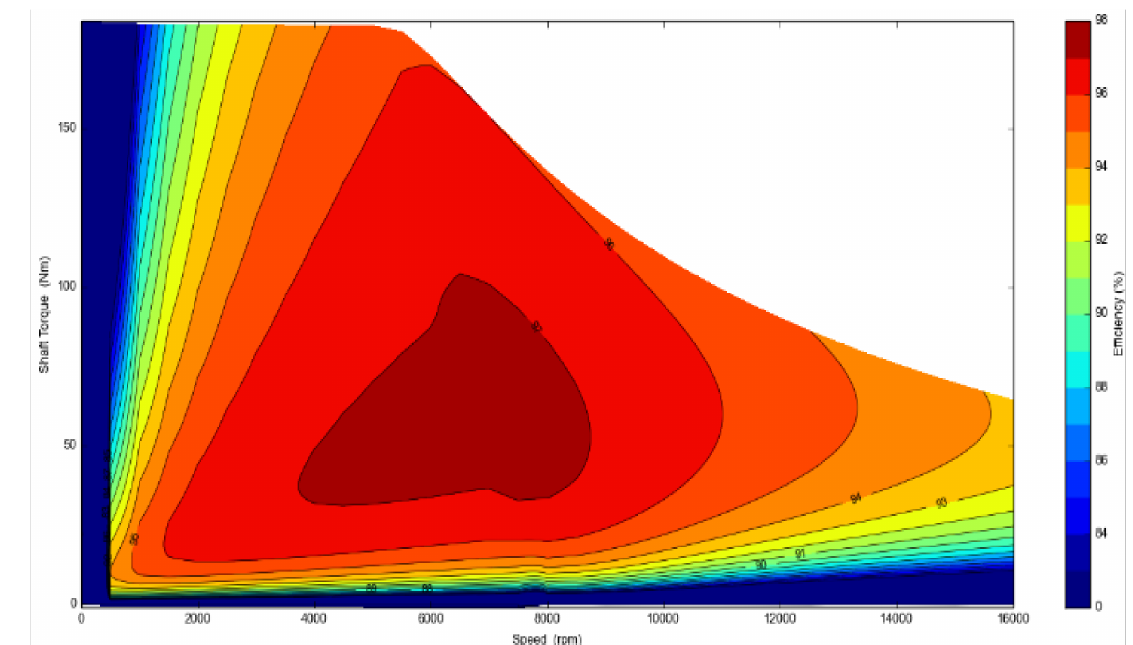
Figure 10. Efficiency map of V + 1-shaped rotor.